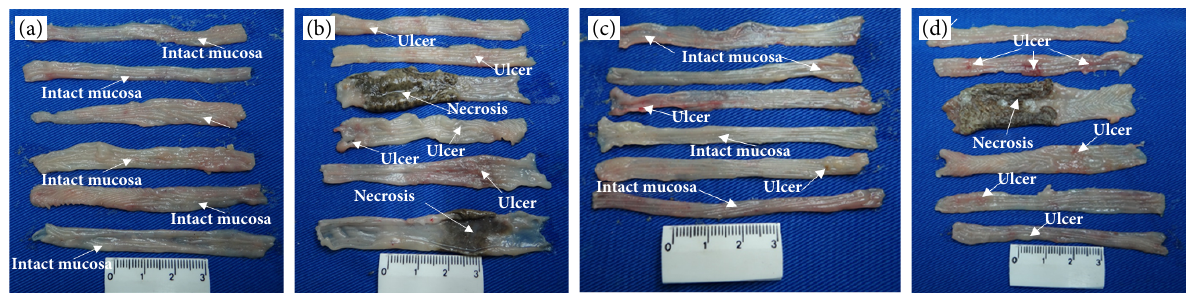
Figure 2 - Representative macroscopic images of six fresh colon 8-cm samples for every group after treatments. Lesions are indicated by arrows. A surgical microscope (DF vasconcelos, São Paulo, Brazil ×10) was used. (a) Normal control group. The mucosa is completely normal in all samples. (b) Rats with colitis and treated with normal saline. Multiple ulcerations, edema, and areas of necrosis are seen. (c) The images of colitis rats treated with curcumin are similar to the normal control rats. (d) Colitis rats treated with mesalazine. Multiple ulcerations of different sizes, edema, necrosis, and dilation of the colonic